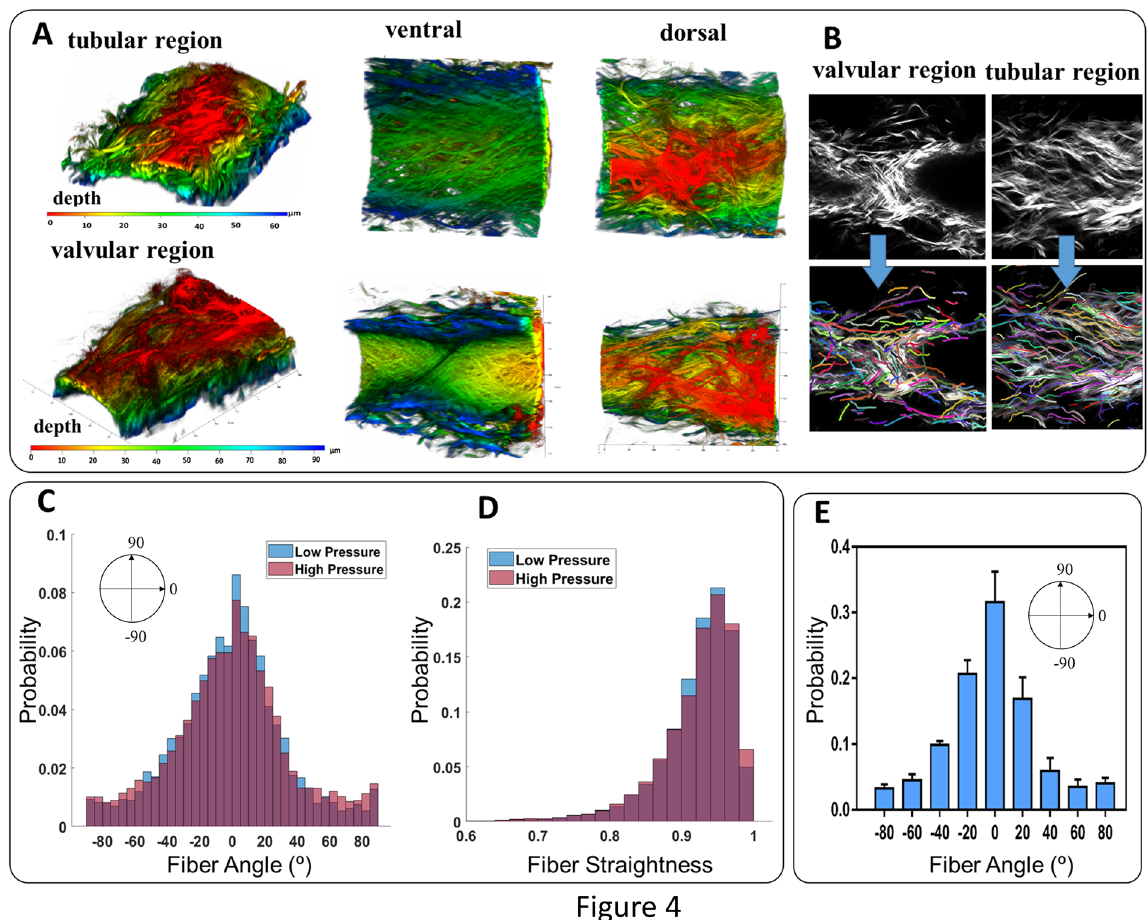
Figure 4. Collagen fiber organization within the wall of a pressurized, unfixed rat tail lymphatic vessel in tubular and valvular regions including reconstruction of SHG imaging of collagen fibers along with dorsal view ventral views (Panel A), the z-stack images obtained from SHG imaging of collagen fibers and respective fiber extractions using CT-FIRE algorithm (Panel B), distribution of collagen fiber angles (Panel C), distribution of collagen fiber straightness within the vessel wall for low (~2 mmHg) and high (~8 mmHg) pressure scenarios (Panel D), and the average distribution of collagen fibers ( n = 5) plotted as the mean value along with the standard deviation (Panel E, the width of each bin is 20° and values of x-axis indicate the center of each bin). The vessels were excised from the base of the tail and mounted on glass pipettes in a custom-made vessel chamber compatible with the microscope. The vessels were unfixed, the pressure was ~2 mmHg, and the axial stretch was ~10%. The axial direction corresponds to 0° and the circumferential direction corresponds to ±